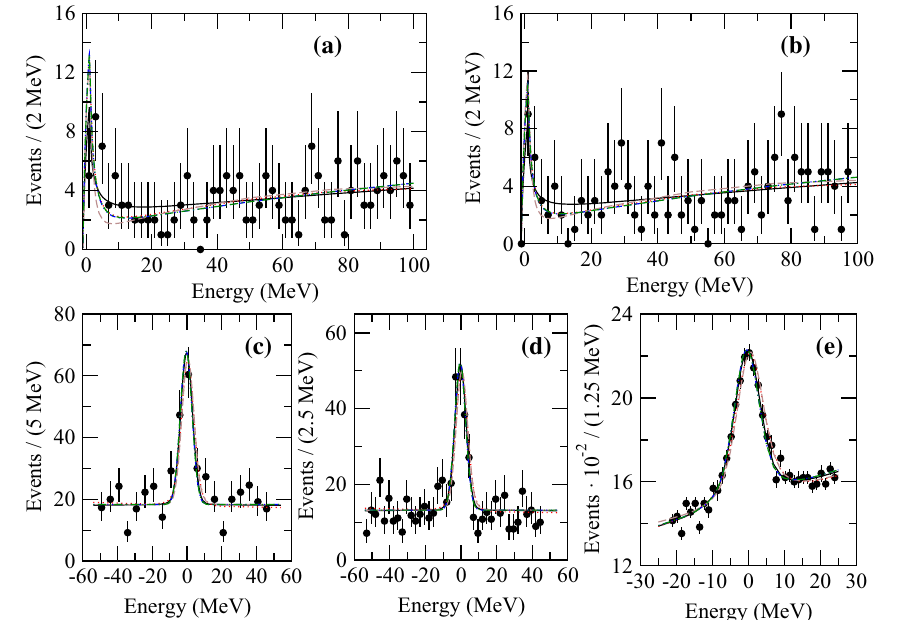
Fig. 4 Fit results for the different event distributions as a function of energy. Panels a and b denote the mode D 0 ¯ D ∗ 0 from BaBar [15] and Belle [17], respectively. Panels c – e denote the mode J /ψπ + π − from BaBar [14], Belle [16], and CDF [18] Collaborations, respectively. The black solid lines correspond to case 1 that employs f ( E ) . The CDD pole contribution is included in the expression of d ( E ) , and the rest